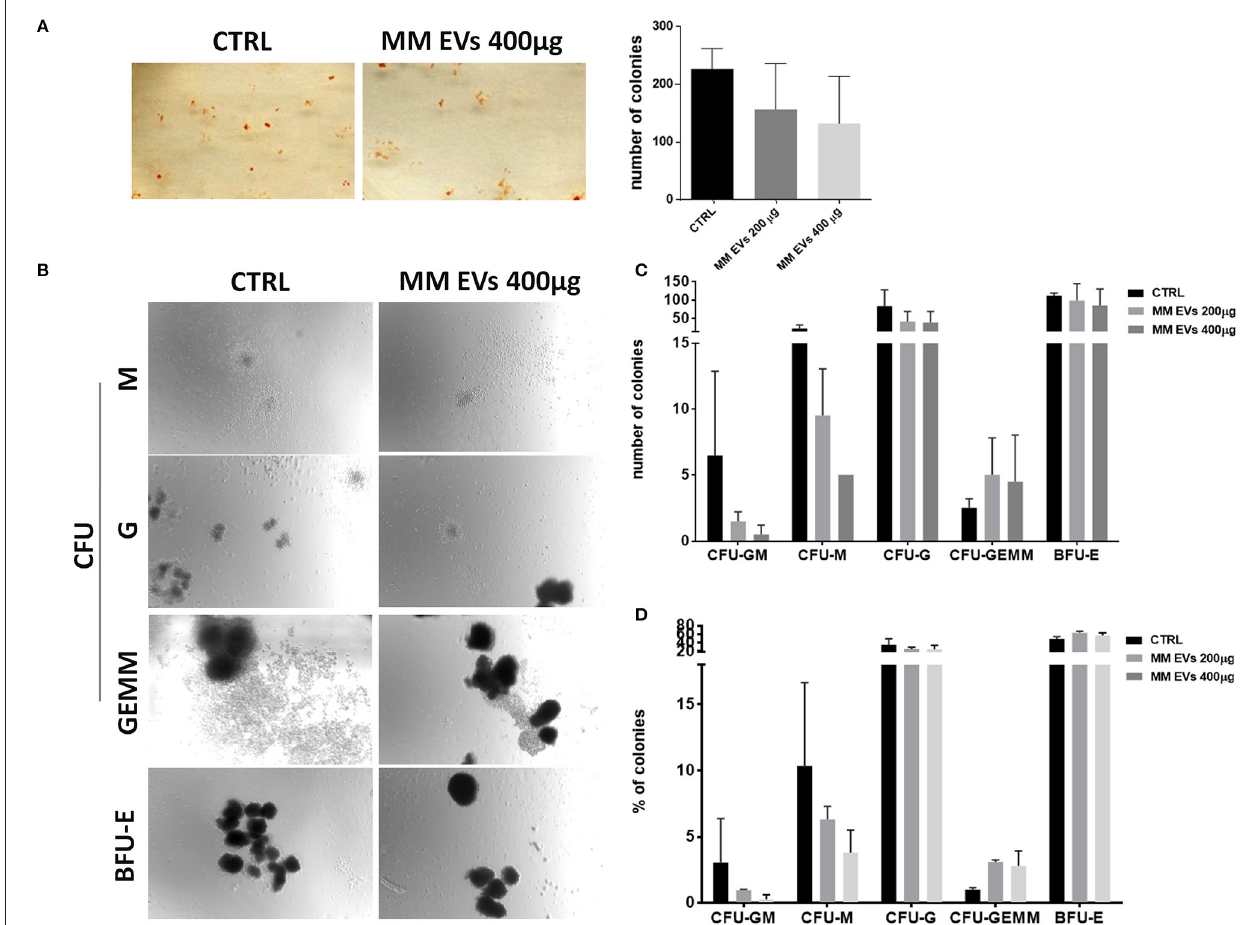
FIGURE 4 | MM-EV effect on HSPC colony formation. (A) Representative photos of colony-forming unit (CFU) assay for HSPCs after 20h of treatment with MM-EVs 400 µ g (left) and means of the total number of colonies after treatment with two doses of MM-derived EVs (MM-EVs 200 µ g, MM-EVs 400 µ g; right); (B) representative photos of CFU-Granulocyte, Macrophage (CFU-GM), CFU Macrophage (CFU-M), CFU Granulocyte (CFU-G), CFU Granulocyte, Erythrocyte, Macrophage, Megakaryocyte (CFU-GEMM), and Burst-Forming-Unit Erythrocyte (BFU-E) after treatment with MM-EVs 400 µ g; means of the total number (C) and proportion (D) of all type of colony after treatment with two doses of MM-derived EVs. The bar graphs represent the average with SD from three independent experiments. MM, multiple myeloma; EVs, Extracellular vesicles; HSPC, hematopoietic stem and progenitor